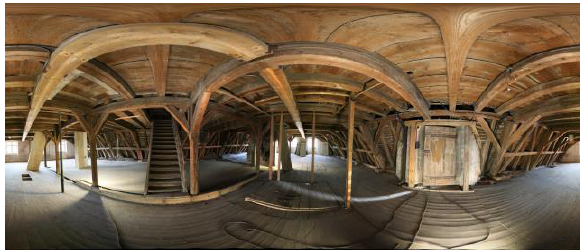
Figure 14: Panoramic view of the first attic level